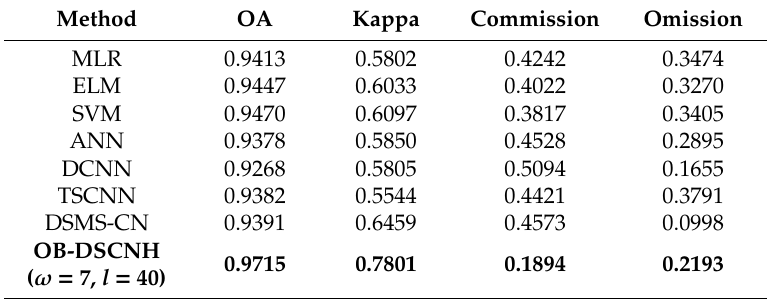
Table 2. Accuracy of the di ff erent change detection methods on the first dataset.